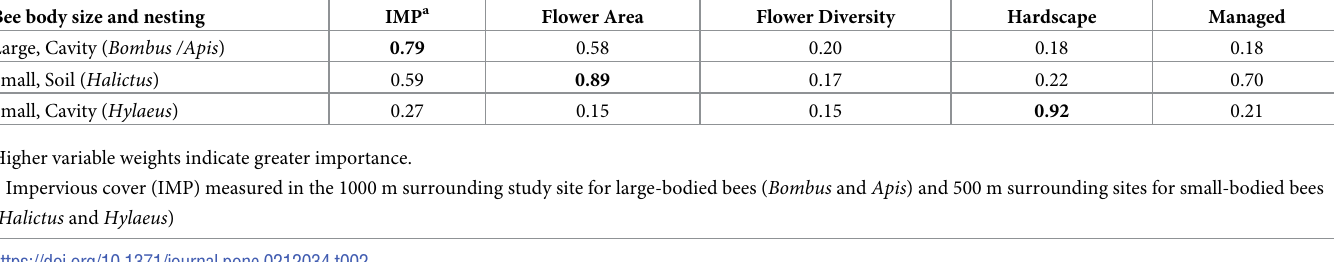
measured at 500 m, accounted for 19% of the model weights, and explained 14% of the varia- tion in bee richness (Table 3). In all competing models, impervious cover was negatively corre- lated with bee richness. Although the correlation was not significant, the trend indicated bee richness decreased as impervious cover increased (R 2 = 0.14, P = 0.10). Variable weights for bee richness were 0.52 for impervious cover, 0.28 for flower area, 0.20 for hardscape, 0.18 for management, and 0.17 for flower diversity (Table 4). (Table 3). The overall best model, which included impervious cover and hardscape, accounted for 28% of the model weights and explained 48% of the variation in the data. Only one compet- ing model was found which included only the variable impervious cover, which accounted for 18% of the model weights and explained 34% of the variation in the data. Impervious cover had the highest variable weight at 0.81 indicating this variable was as the most influential vari- able explaining community composition and had a significant negative relationship with com- munity composition (Table 4; Fig 3, R 2 = 0.34, P = 0.0078). Hardscape had the second highest variable weight at 0.60 followed by management with a weight of 0.20. Flower area and flower diversity had the lowest variable weights at 0.18 and 0.14, respectively. Table 2. Variable weights calculated for each explanatory variable in the full models for abundance. Bee body size and nesting IMP a Flower Area Flower Diversity Hardscape Managed Large, Cavity ( Bombus /Apis ) 0.79 0.58 0.20 0.18 0.18 Small, Soil ( Halictus ) 0.59 0.89 0.17 0.22 0.70 Small, Cavity ( Hylaeus ) 0.27 0.15